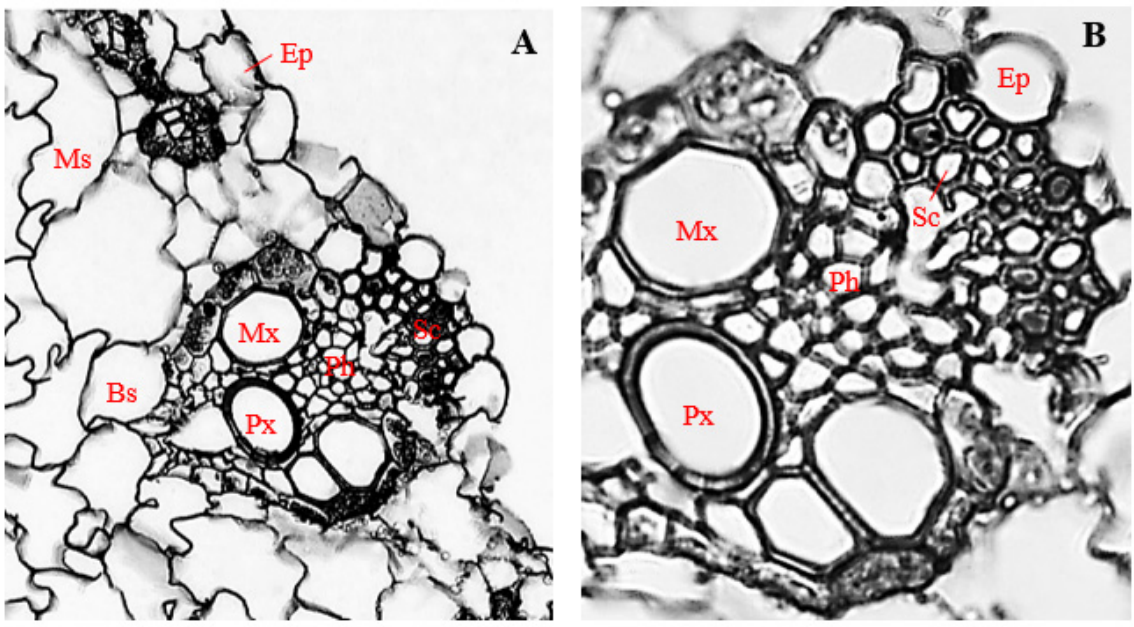
Figure 9. Transverse section of uninoculated corn leaf. ( A ) Magnification 200×; ( B ) magnification 400×. Ep, epidermis; Sc, sclerenchyma; Ph, phloem; Mx, metaxylem; Px, protoxylem; Bs, bundle sheath; and Ms, mesophyll.